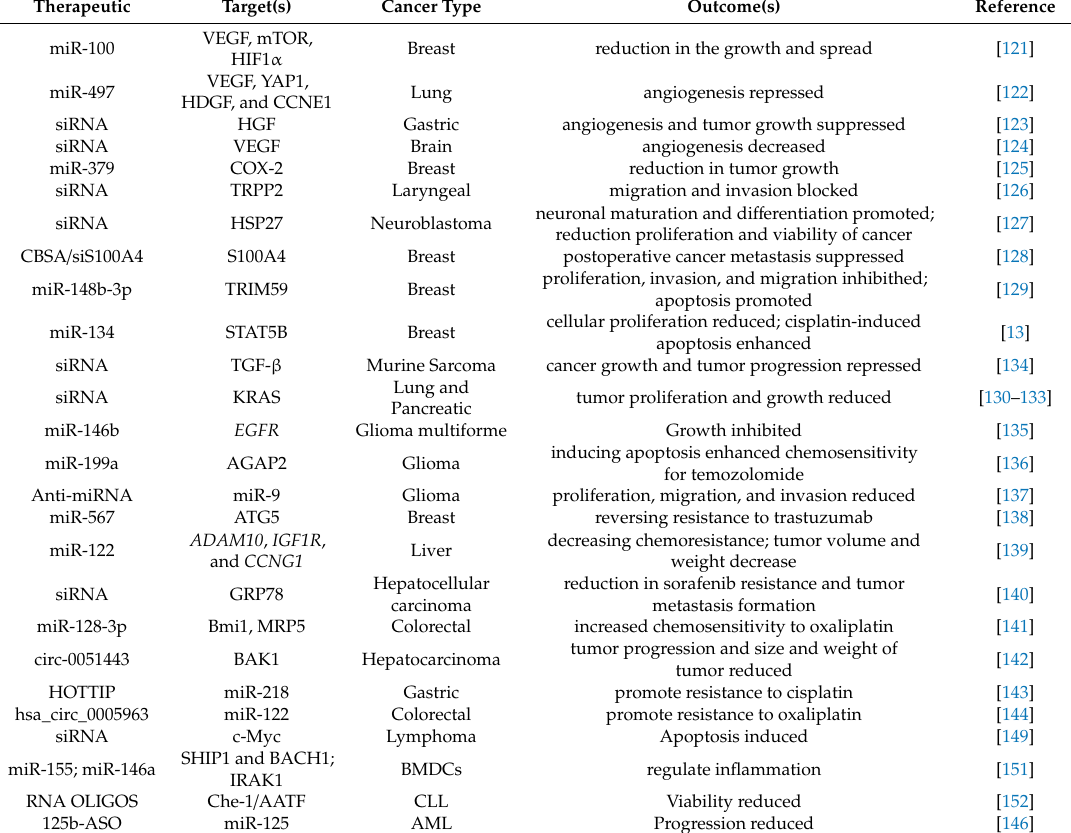
Table 4. List of acid nucleic molecules used as therapeutic in cancer, and related targets.